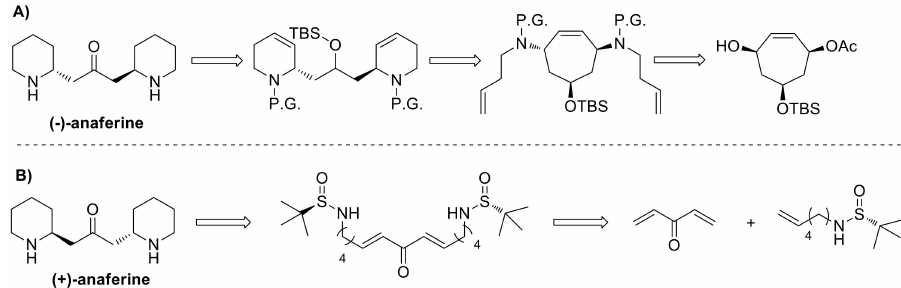
Figure 3. ( A ) Retrosynthetic pathway for the synthesis of (-)-anaferine, reported by Stapper and Blechert; ( B ) Retrosynthetic pathway for the synthesis of ( + )-anaferine, reported by del Pozo and co-workers. Stapper and Blechert’s strategy took advantage of an enantiopure cycloheptene precursor,